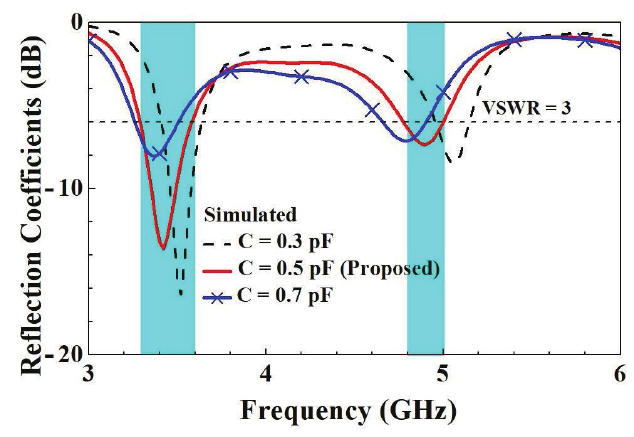
Figure 13. Comparison of simulated reflection coefficients with changes in C .